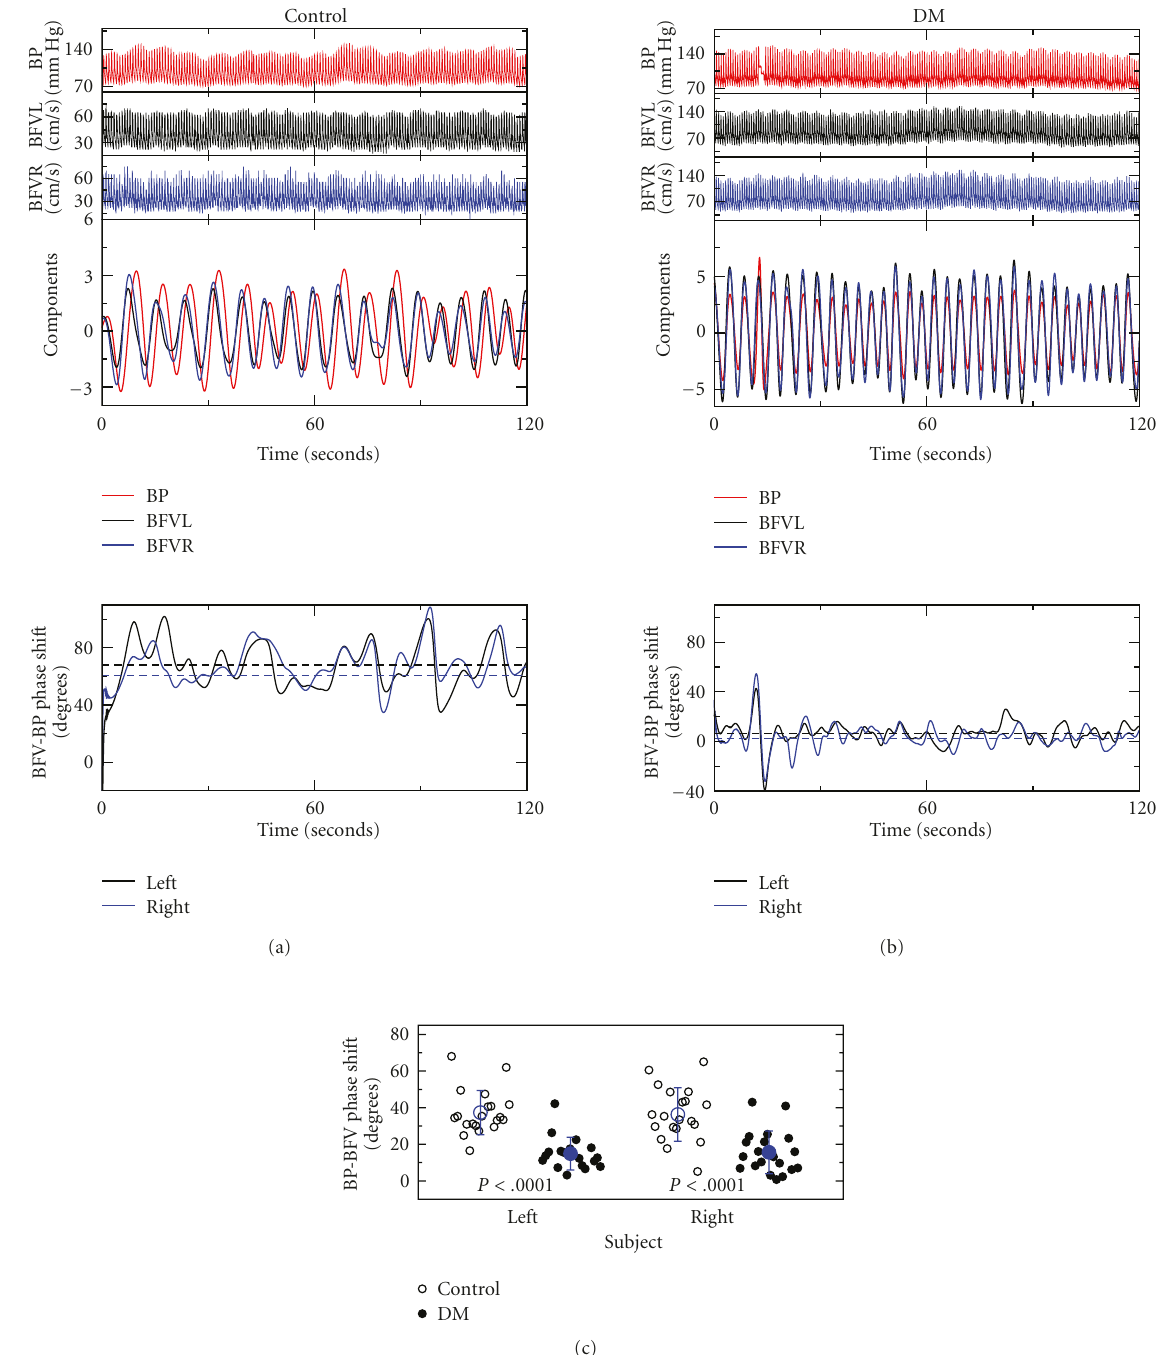
Figure 6: Spontaneous oscillations of blood pressure (BP) and cerebral blood flow velocity (BFV) in (a) a 72-year-old healthy control woman and (b) a 52-year-old man with type 2 diabetes during supine baseline. Figure 6(a) was adapted from [16]. BP, left and right BFVs (panels 1 to 3 in (a) and (b)) were decomposed into di ff erent modes using ensemble empirical mode decomposition algorithm, each mode corresponding to fluctuations at di ff erent time scale. The components corresponding to respirations at frequency ranging from ∼ 0.1 to 0.4 Hz (the forth panels in (a) and (b)) were extracted and used for the assessment of BP-BFV relationship. Instantaneous phases of BP and BFV oscillations (solid lines in the bottom panels of (a) and (b)) were obtained using the Hilbert transform. There were large time/phase delays in BP oscillations compared to the BFV oscillations. For each subject, the average BFV-BP phase shift (horizontal dashed lines in bottom panels of (a) and (b)) was obtained as the average of instantaneous BFV-BPV phase shifts during the entire 5-min supine baseline. (c) Phase shifts between spontaneous oscillations of BP and BFV were much smaller in diabetes group than in healthy control group ( P < . 0001). The group averages of control and diabetes are shown in blue symbols with error bars as the standard deviations. There was no significant di ff erence in phase shifts between left and right blood flow velocities in both control and diabetes